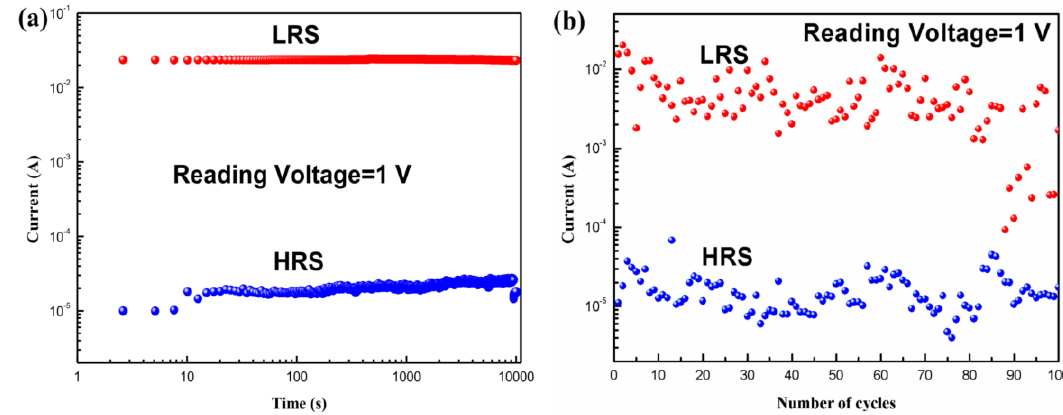
Figure 6. ( a ) Retention properties; ( b ) Endurance properties of Al/ Bombyx mori body fluid film/ITO biomemristor.